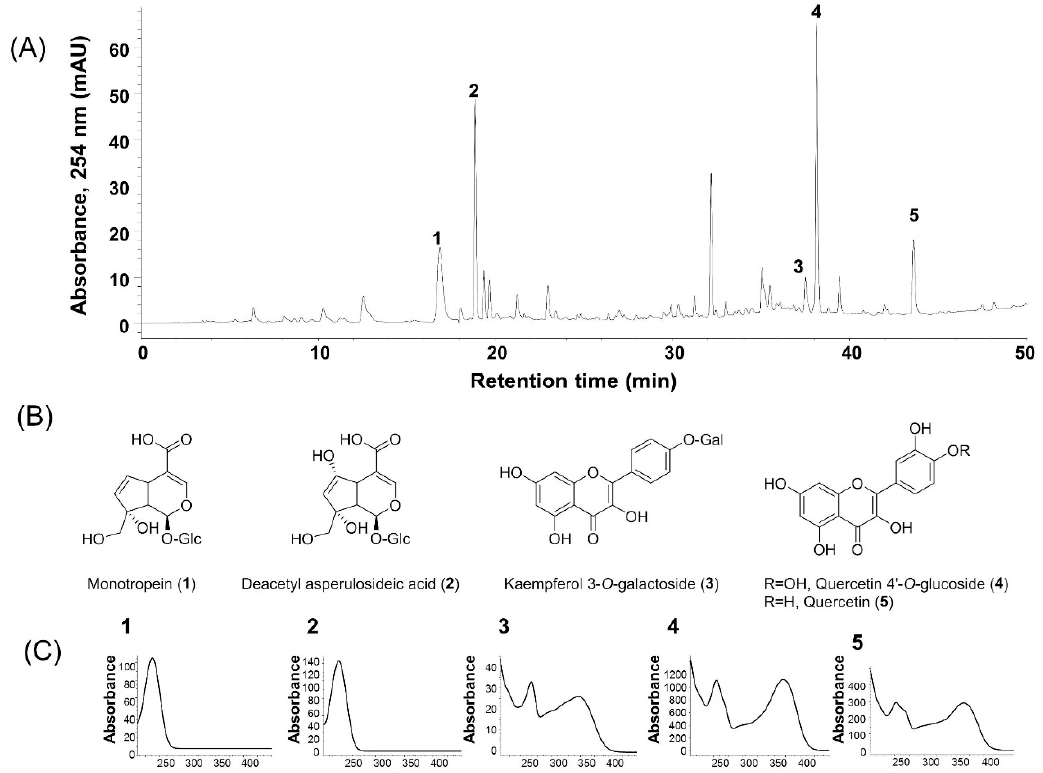
Figure 5. ( A ) High performance liquid chromatography (HPLC) profile of MOTILIPERM. ( B ) Chemical structure of major compounds. Monotropein ( 1 ), deacetylasperulosidic acid ( 2 ), kaempferol 3-O-galactoside ( 3 ), quercetin 4 ′ -O-glucoside ( 4 ), and quercetin ( 5 ). ( C ) UV spectra of major compounds.